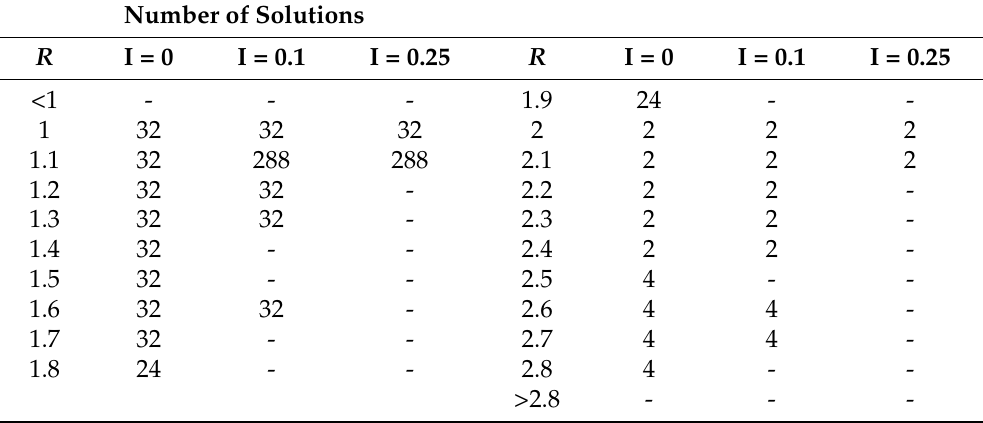
Table 2. Influence of the uncertainty on the number of solutions obtained with different coverage radius—scenario